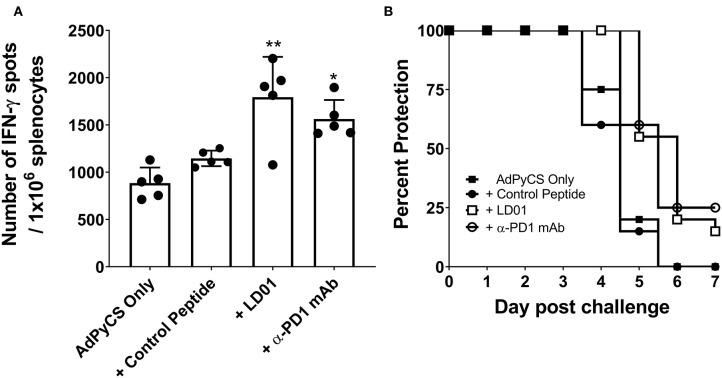
LD01 increases antigen-specific CD8+ T cell numbers following AdPyCS vaccination. (A) At day 12 post-AdPyCS immunization, immunogenicity was assessed by measuring the number of splenic PyCS-specific, IFN-γ-secreting CD8+ T cells using the ELISpot assay after stimulation with the H-2kd restricted CD8 epitope SYVPSAEQI. Data are expressed as the mean ± SD. Data from one of two independent experiments are shown. Significant differences between AdPyCS + control peptide and treated mice were determined using a one-way ANOVA multiple comparisons test and are denoted by *p < 0.05 and **p < 0.005. (B) Immunized and treated mice were challenged with Py 17XNL sporozoites IV. Data represent two independent experiments (n = 10/group/experiment) and are expressed as the mean percent protection. Parasitemia was assessed beginning at day 3 post-challenge, and sterile protection was defined as the absence of parasite detection in the blood through day 7 by microscopic examination of Giemsa-stained thin smears.